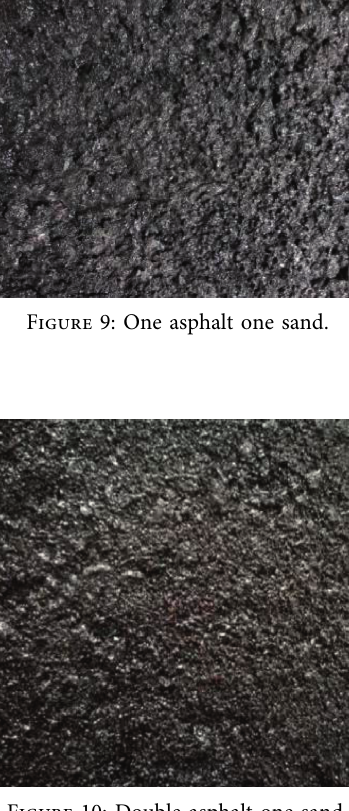
Figure 8: Wear track of specimen during accelerated wear.